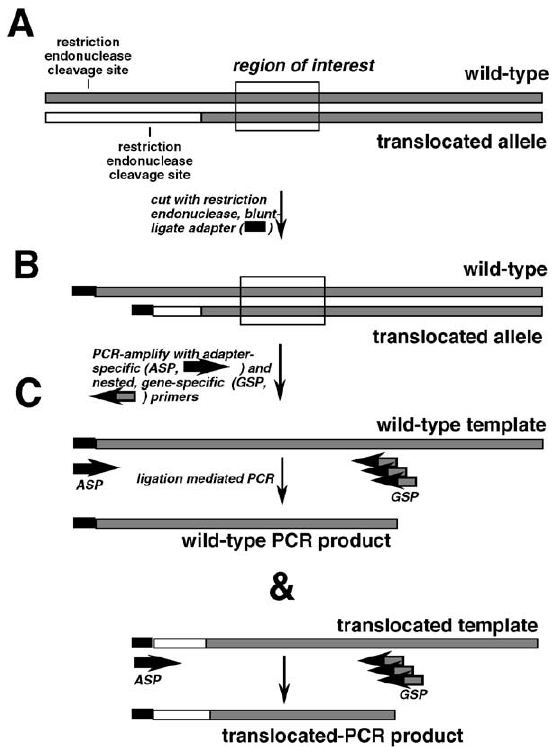
Fig. 1. Schematic outline of a LM-PCR based strategy for detec- tion of chromosomal breakpoints. (A) Anatomy of the wild-type and translocated alleles around the region of interest. In the wild-type al- lele, a specific endonuclease restriction site is chosen within a de- fined distance upstream of the region of interest. In case of a translo- cated allele, this particular restriction site is lost, and a new specific site is located randomly either up- or downstream of the site of the wild-type gene. (B) After digestion with the corresponding restric- tion enzyme, the first gene specific oligo is annealed and a primer ex- tension performed. Then, an amplification adapter is ligated (solid). (C) PCR amplification is performed with an adapter-specific primer (ASP) and a second gene specific primer (GSP). In case of an under- lying translocation, this results in amplification of the wild-type gene and an additional PCR product of different size from the translocated